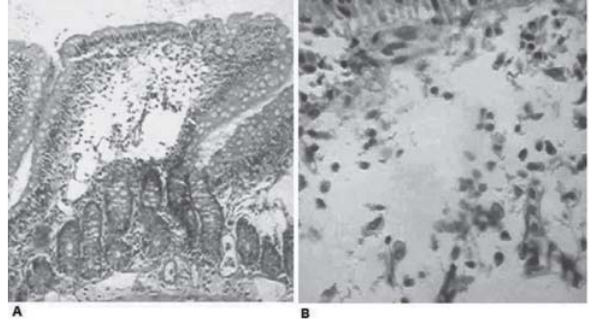
Fig. 4 - Fotomicrografia do grau 2 da classificação de Chiu et al. [6] (HE, A x 100, B x 400) - rato 4 do grupo B